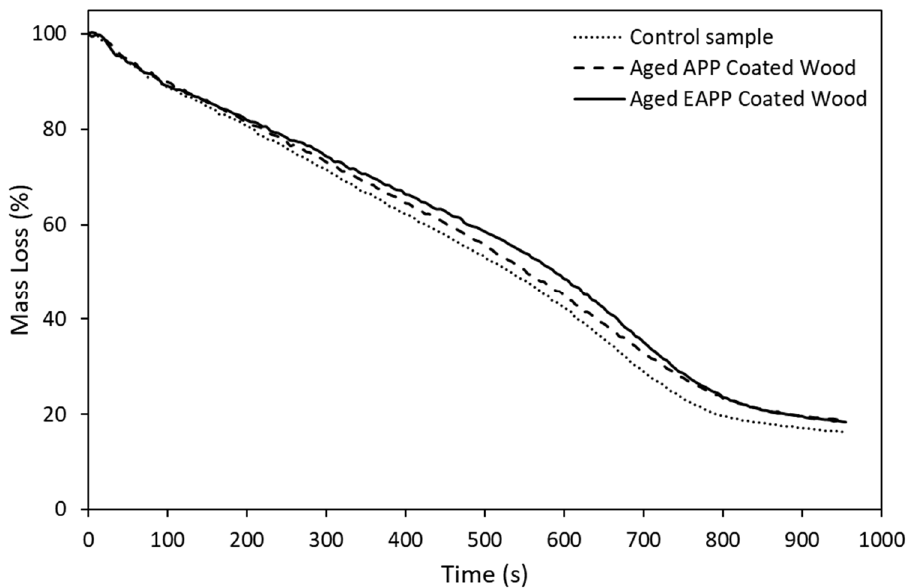
Figure 9. MLR curves of aged intumescent coated wood samples and control wood sample.